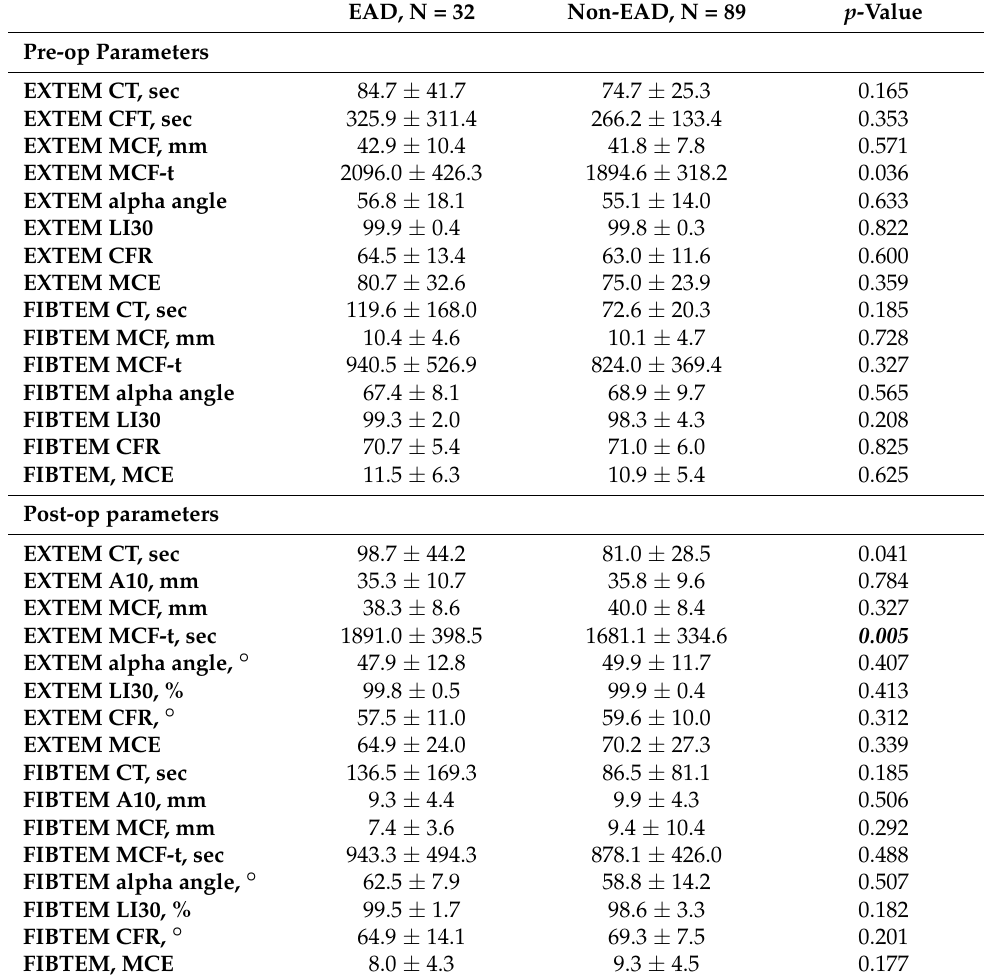
Table 3. Results of thromboelastometric assays according to development of EAD or lack thereof.